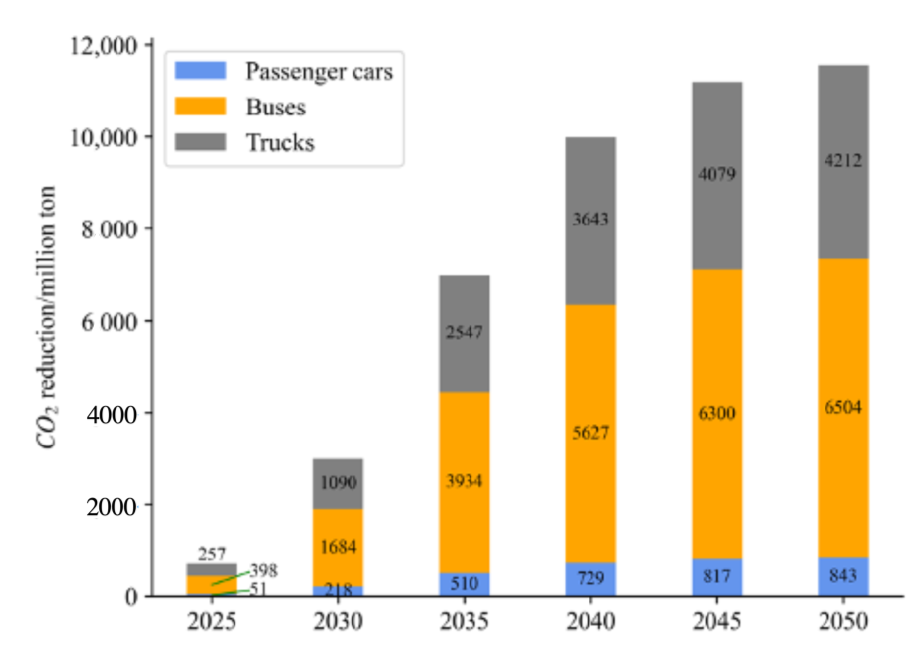
Figure 4. CO 2 emission reduction potential under BAU.